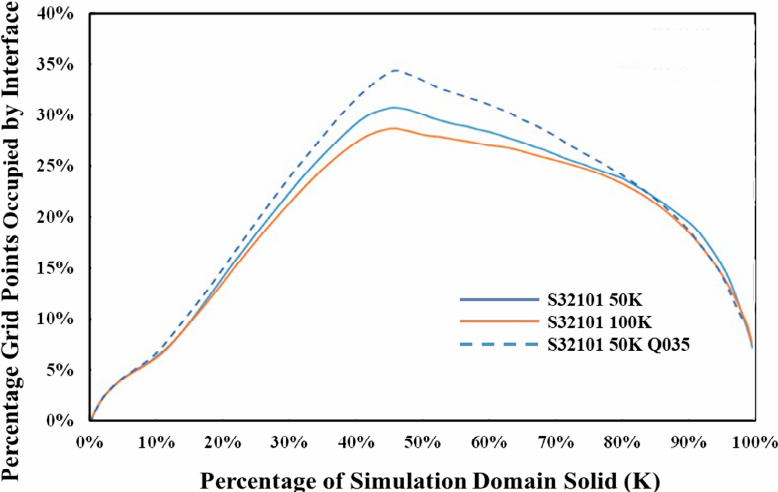
Figure 16. Influence of superheat on microstructural fineness of S32101, 50 °C and 100 °C superheat at 10 mm in the cast slab, when increasing heat flux at the boundary.